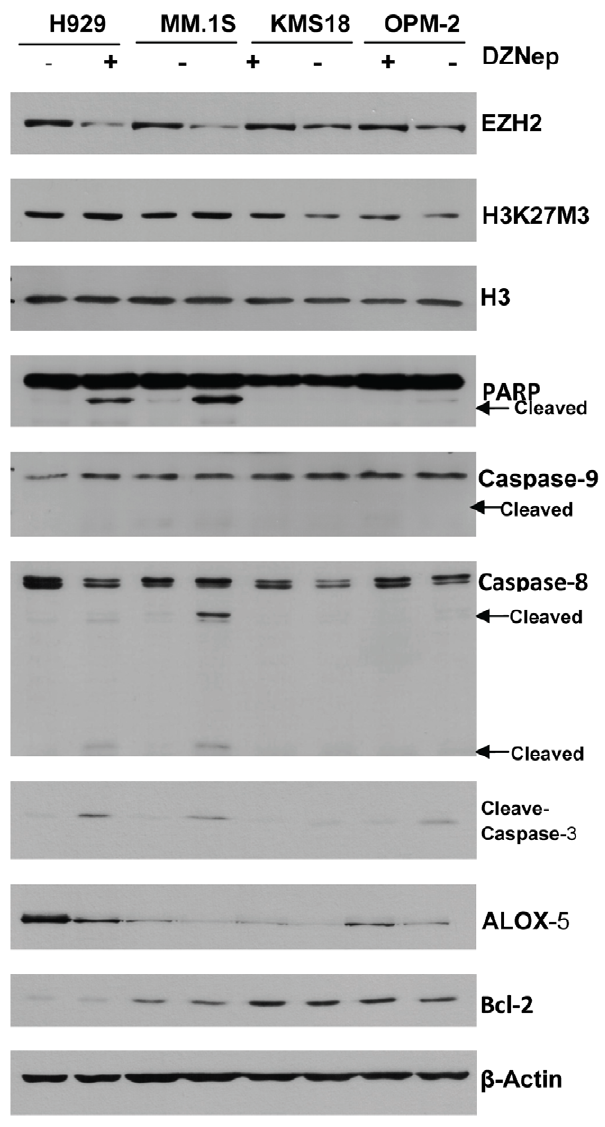
Figure 3. Analysis of DZNep effects by Western-blot and RT- PCR. DZNep reduced EZH2 and ALOX5 levels, and induced caspase- dependent cell apoptosis. Cells were treated with 0.5 umol/L DZNep for 72 h, and then whole-cell lysates were analyzed by